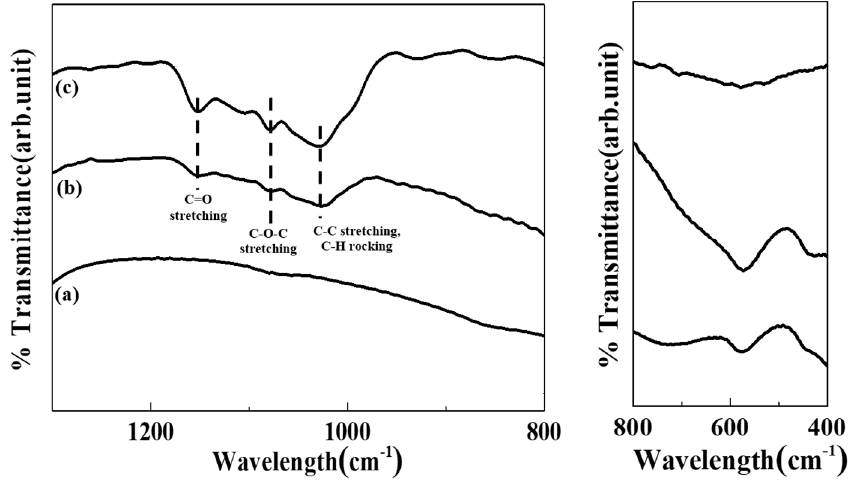
Figure 2. Fourier transform infrared spectra of ( a ) MgFe–LDH, ( b ) Zingiber officinale extract–layered double hydroxide (ZOE–LDH) hybrid and ( c ) ZOE.